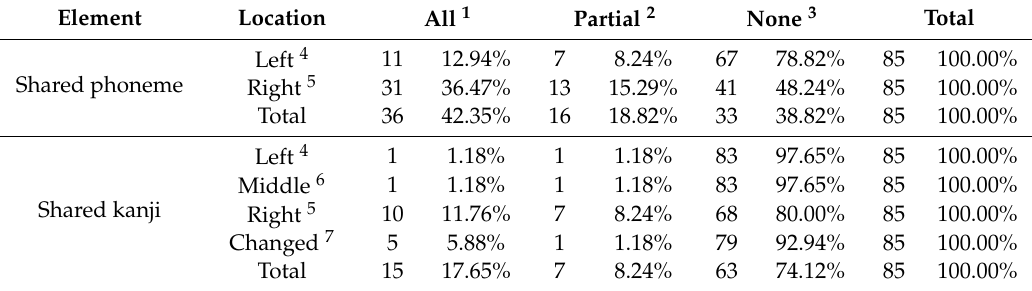
Table 7. Number of paired names with commonalities between siblings